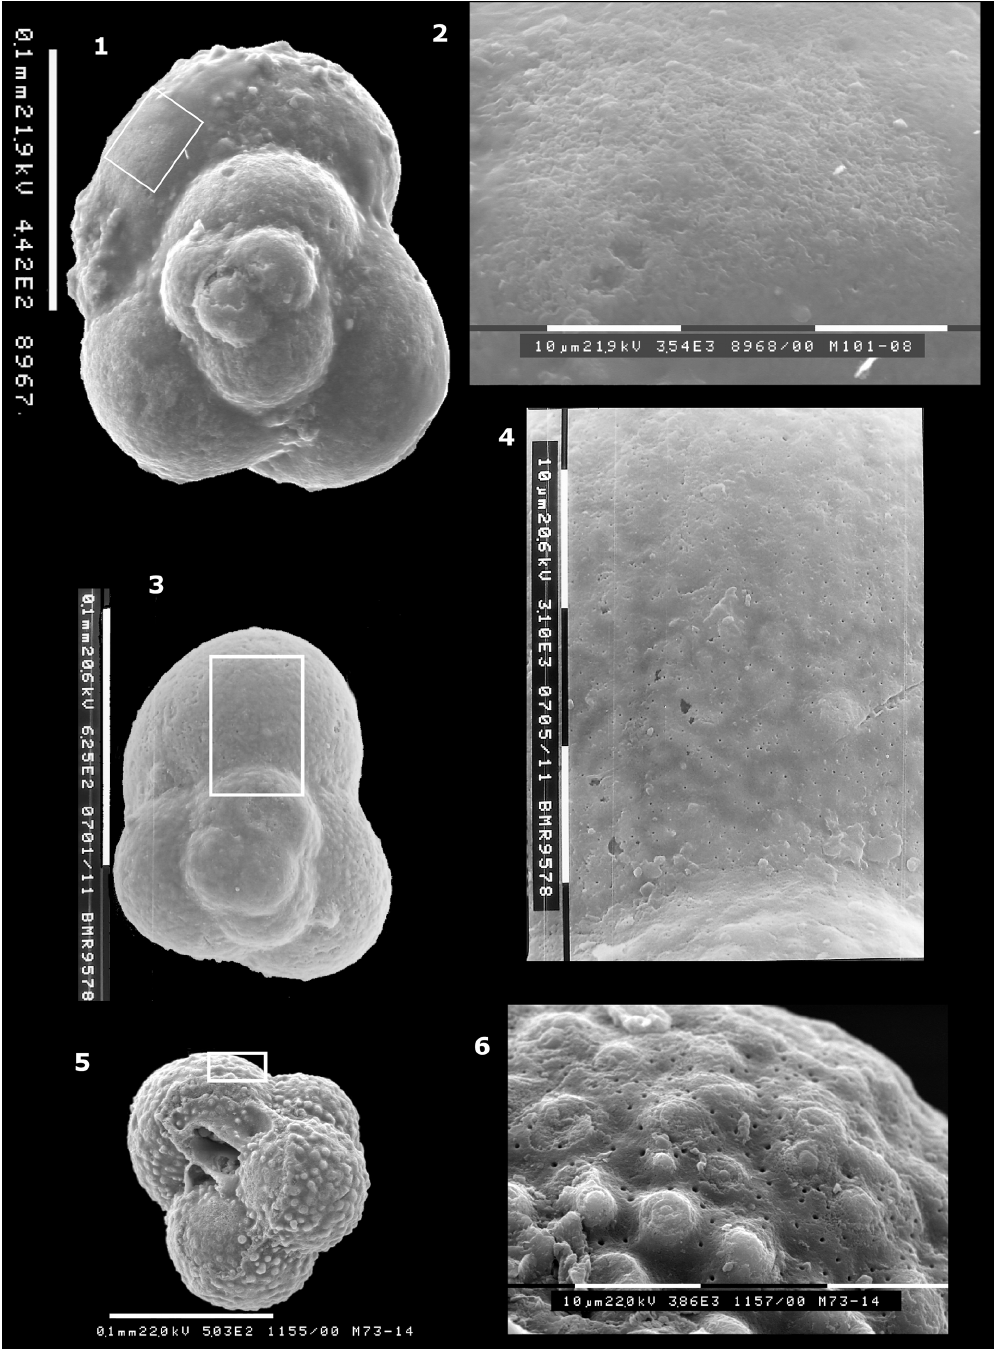
Figure 7. Contrasting wall structures, outer surface. (1–2) Mermaidogerina loopae n. gen. n. sp., Paratype WAM 18.26/M101-08; (1) spiral view, showing smooth-walled test, except for scattered pseudomuricae on the final (ninth) chamber. Scale bar: 100µm. (2) Part of surface of final chamber within box in (1) ; showing smooth, slightly etched surface but lacking tubercules or pseudomuricae. Each scale bar at base: 10µm. Specimen from sample BMR 96/DR28/16. (3–4) Mermaidogerina loopae n. gen. n. sp., WAM 18.23/M11-35. (3) Spiral view of triserial test; (4) detailed view of wall of final chamber in box in (7: 3) , showing smooth surface, finely perforate on final chamber. Earlier whorl at bottom of image shows very low raised areas. (5–6) Globuligerina altissapertura n. sp., Paratype WAM 18.5/M73-14 (see also Fig. 4: 2–3); (5) whole specimen; note the scar of the final bulla that is broken off. Scale bar: 100µm. (6) Well-preserved pseudomuricae and pore structure on the last-preserved chamber (area in box in (5) ). The layer of secondary lamination on these pseudomuricae is presumably associated with formation of the terminal bulla. Each scale bar: 10µm. (3–6) Specimens from sample BMR